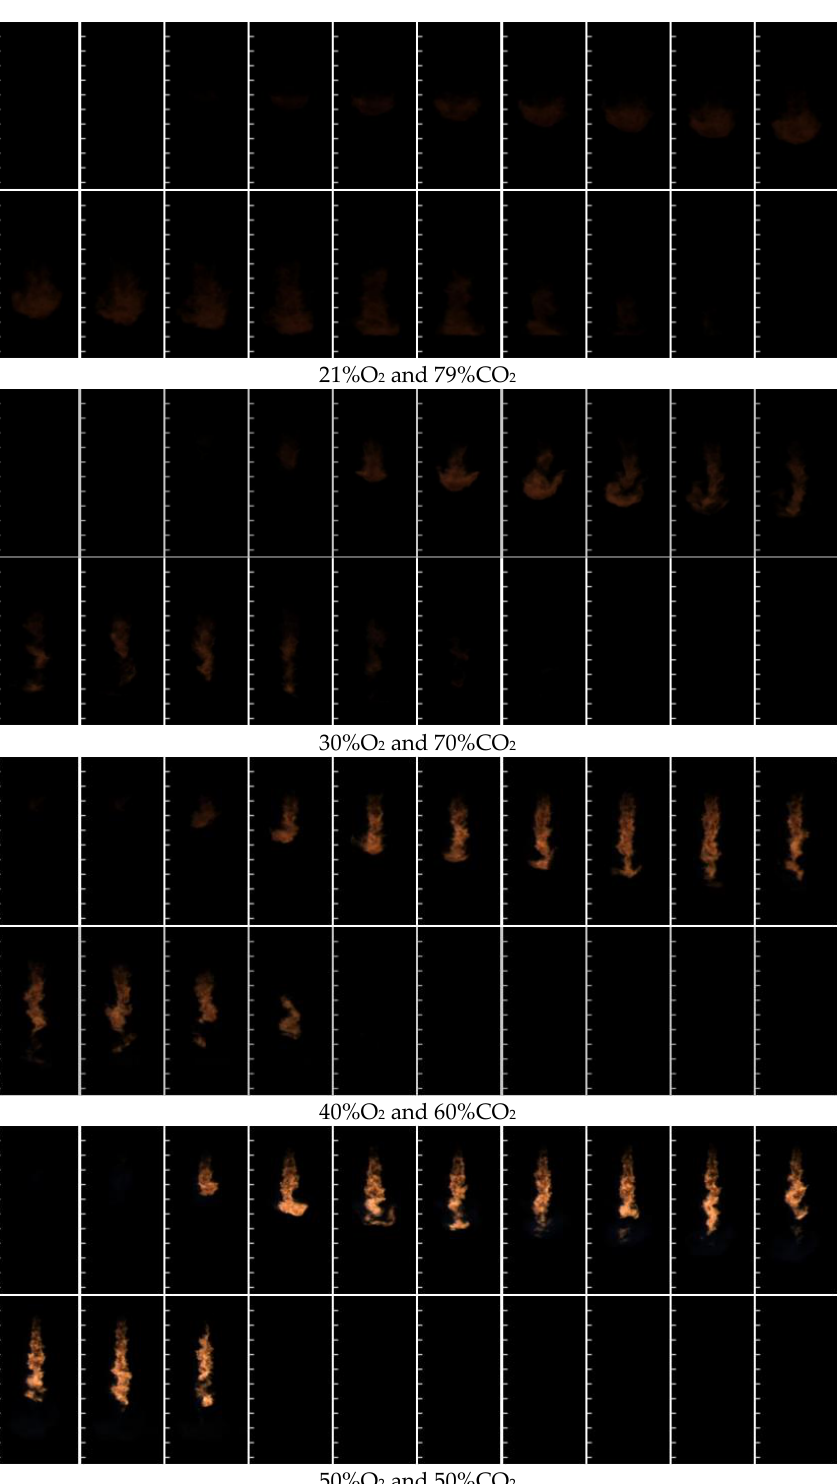
much lower than that of N 2 , which weakens the flame propagation. This test indicates that diesel undergoes a chemical reaction in a 21% O 2 and 79% CO 2 environment.